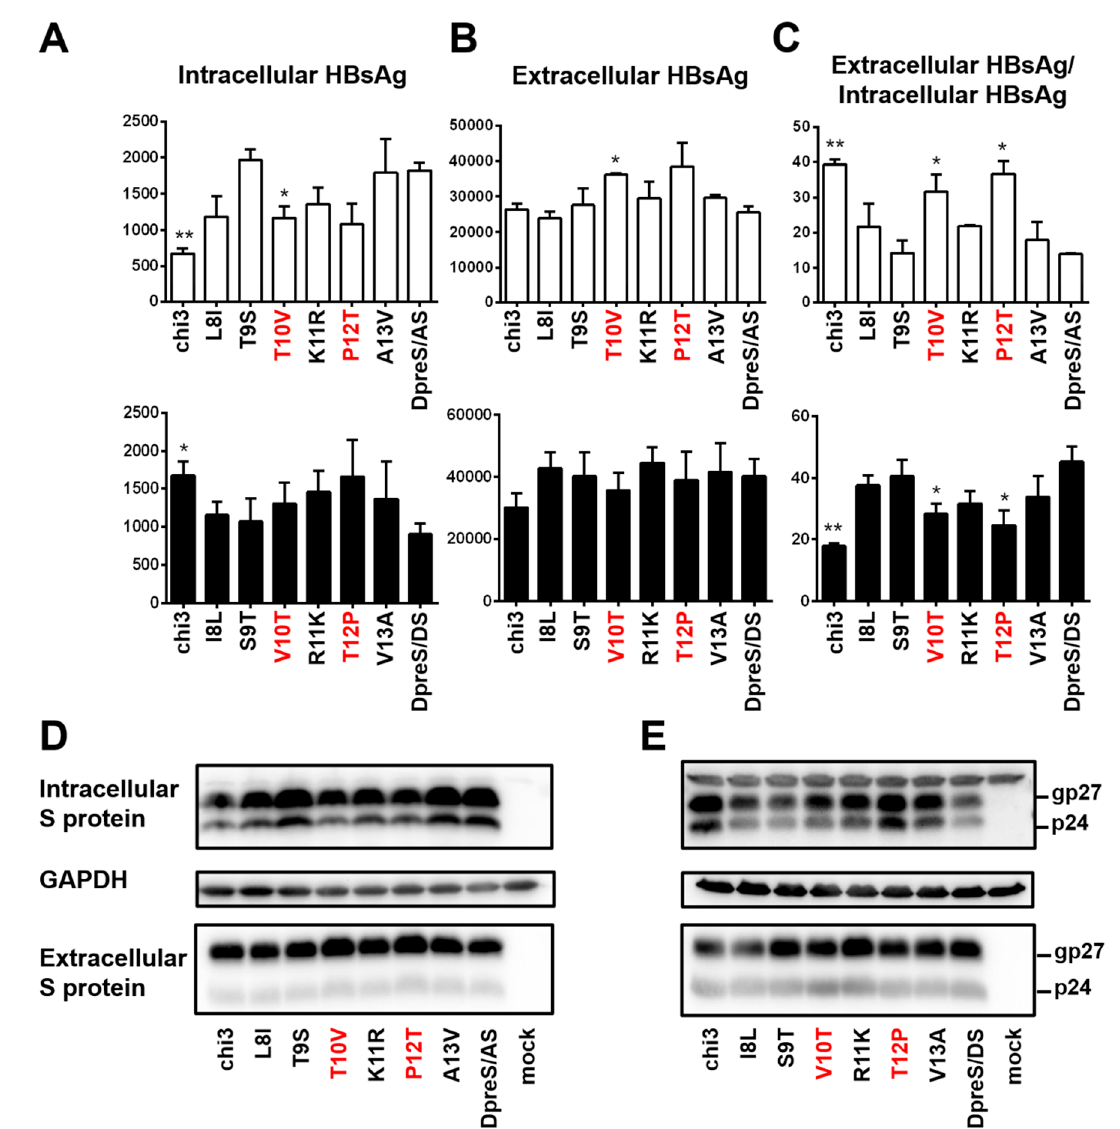
Figure 10. Site-directed mutagenesis to identify residues in the S protein responsible for efficient HBsAg secretion by geno1.2. Huh7 cells in 6-well plates were transfected with 0.7 mer S construct of DpreS/AS or DpreS/DS, or chimeric construct chi3, or one of the six site-directed mutants targeting divergent residues 8–13. ( A – C ) Total intracellular ( A ) and extracellular ( B ) levels of HBsAg (OD 450 ) averaged from three independent transfection experiments, and the calculated ratio of extracellular/intracellular HBsAg ( C ). The top and bottom panels are based on DpreS/AS and DpreS/DS, respectively. Statistical difference between the original construct (DpreS/AS or DpreS/DS) and a mutant construct was analyzed by one-way ANOVA (* p < 0.05, ** p < 0.01). ( D , E ) Western blot analysis of intracellular and extracellular S protein from the DpreS/AS series ( D ) and DpreS/DS series ( E ). Same volume of cell lysate or culture supernatant was used, and GAPDH served as loading control for cell lysate.